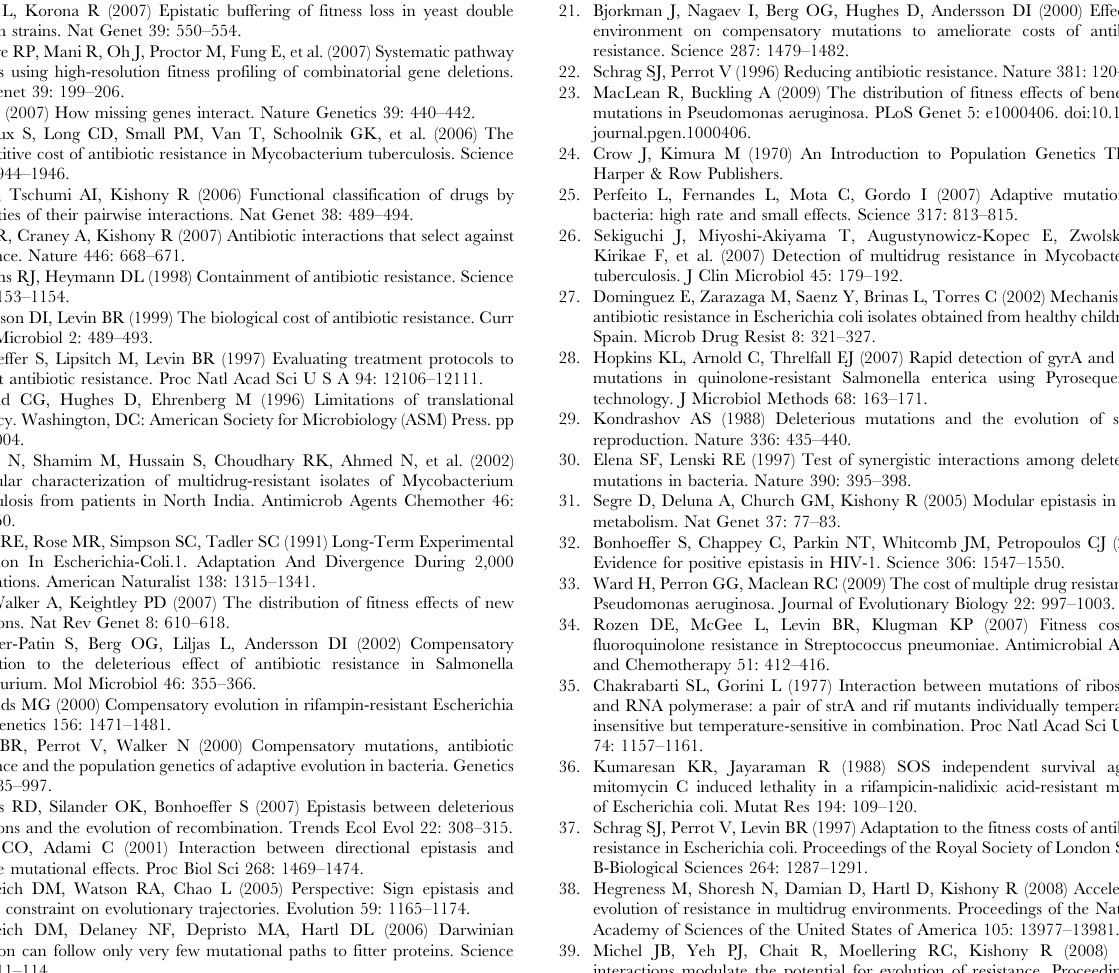
Figure S3 Evidence of positive epistasis in spontaneous double resistant clones.